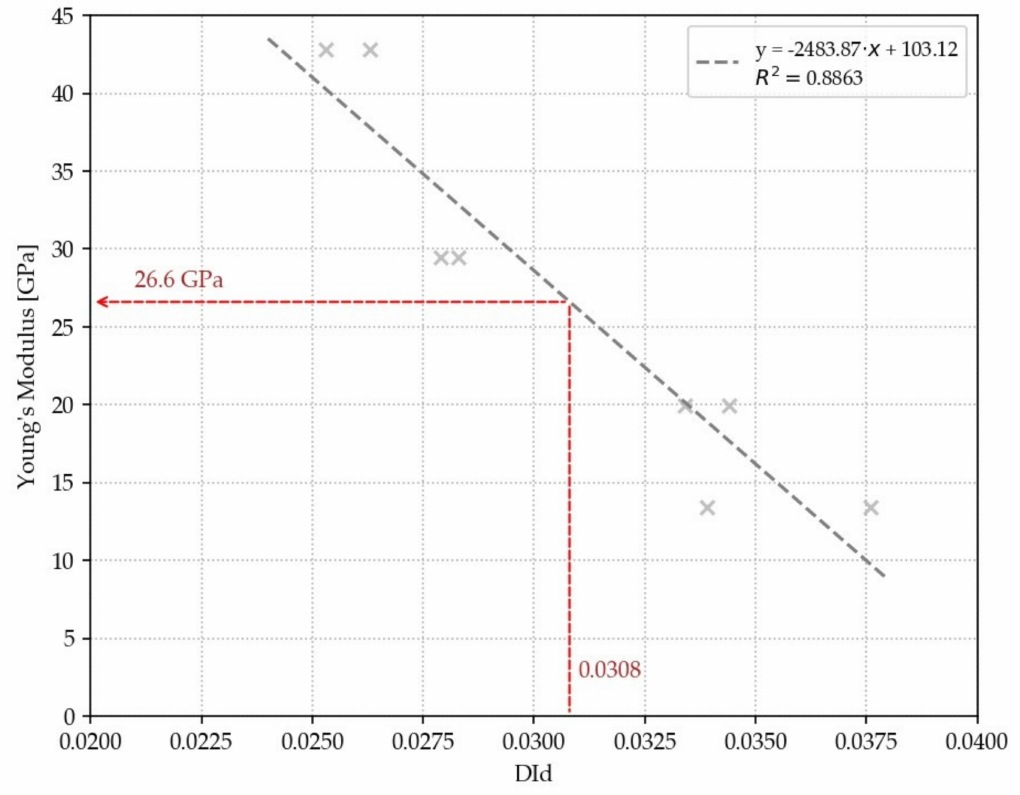
Figure 6. Residual Young’s modulus evaluation with DI d .